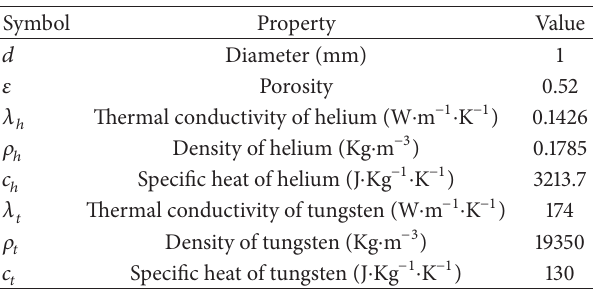
Figure 7: Heat deposition in the target zone. Table 1: The material properties of tungsten granules and helium.